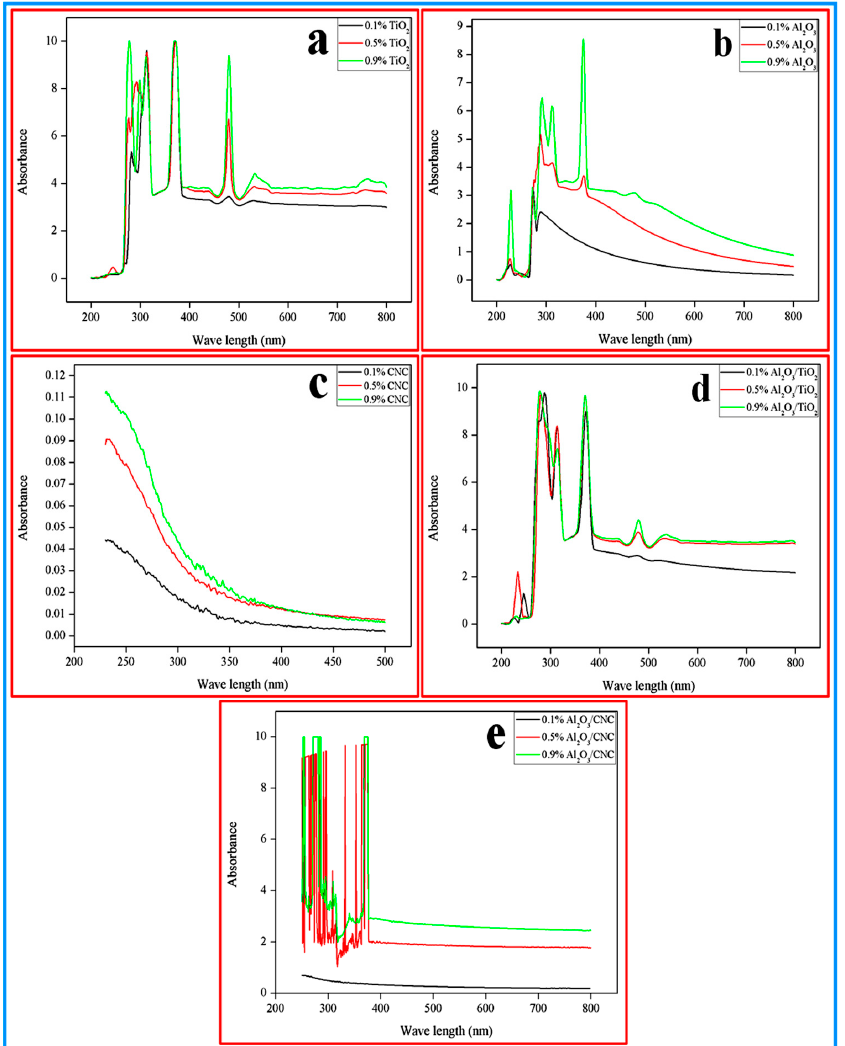
Figure 4. UV spectrum of ( a ) TiO 2 , ( b ) Al 2 O 3 , ( c ) CNC, ( d ) Al 2 O 3 /TiO 2 and ( e ) Al 2 O 3 /CNC nanofluids with various concentrations.